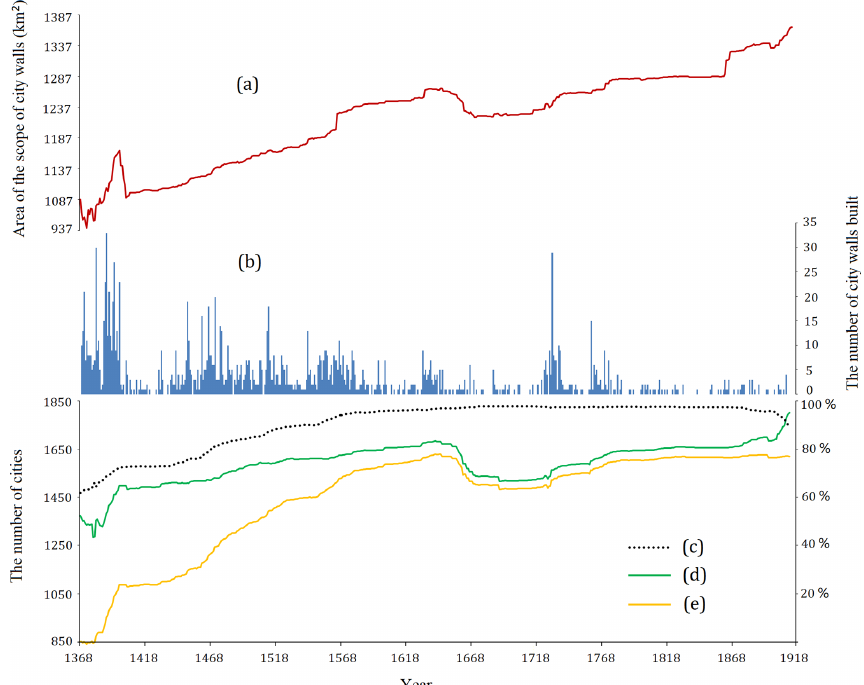
Figure 7. Time series of cities and city walls in the Ming and Qing dynasties (1368–1911). (a) The time series of the area of the extent of city walls. (b) The number of city walls built. (c) Walled cities’ percentage of the total number of cities. (d) The total number of cities. (e) The total number of walled cities.